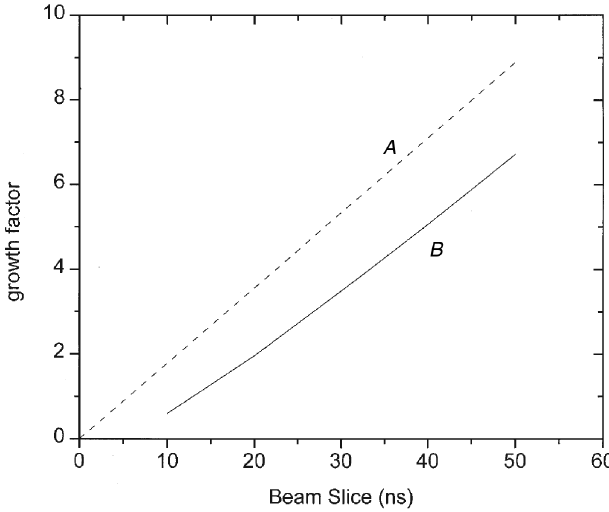
FIG. 3. Same as Fig. 1 for Lorentzian channel conductivity